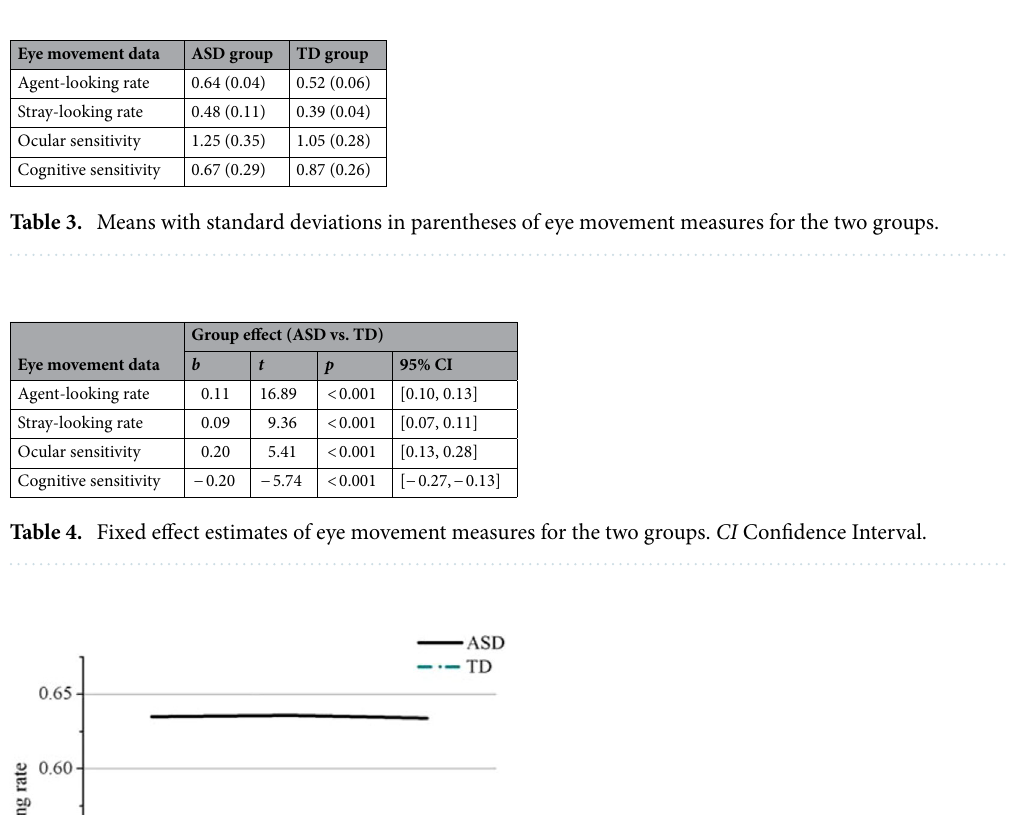
Figure 4. Accuracy of detection of the two groups in the 75° chase subtlety condition. Note ** p < 0.01, *** p < 0.001.